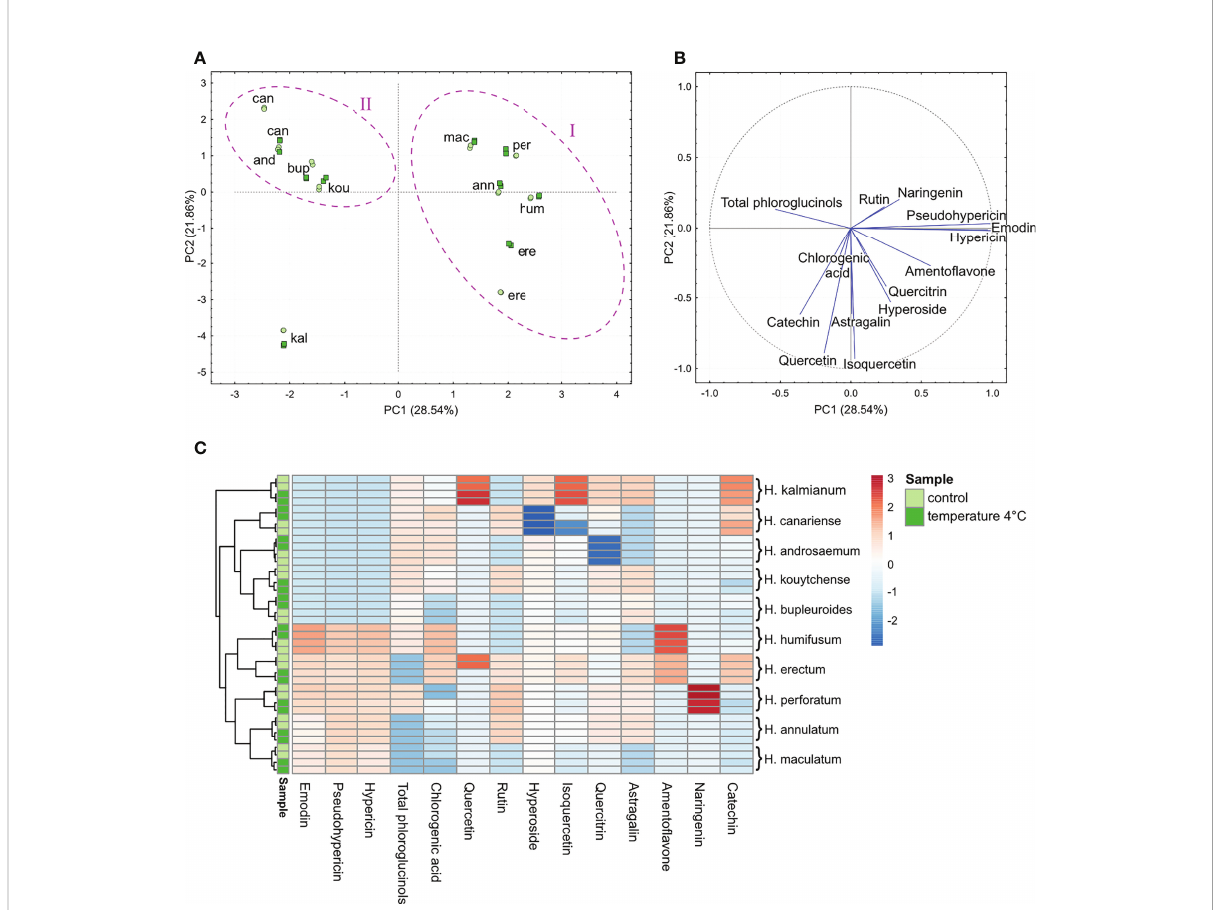
FIGURE 2 The PCA (A, B) and HCA (C) analyses of anthraquinones, phloroglucinols, chlorogenic acid and fl avonoids quanti fi ed in the extracts of shoots of in vitro- grown H.ypericum spp. Clustering of species (cases) is highlighted with a magenta ellipse drawn around each cluster (A) in relation to metabolite contents (variables) (B) . Each species is represented by two biological replicates (two points per species). The HCA dendrogram (C) shows clustering of the species according to the branches. Each square in the heatmap dendrogram (C) represents the relative content of a metabolite. The red and blue color represent an increase and a decrease of relative metabolite content. Light green and dark green color of the samples indicate the metabolite contents in control plants and plants exposed to temperature of 4°C. (For interpretation of the references to color in this fi gure legend, the reader is referred to the Web version of this article.) kou, H. kouytchense ; and, H. androsaemum ; bup, H. bupleuroides ; per, H. perforatum ; mac, H. maculatum ; ere, H. erectum ; hum, H. humifusum ; kal, H. kalmianum ; can, H. canariense ; ann, H. annulatum